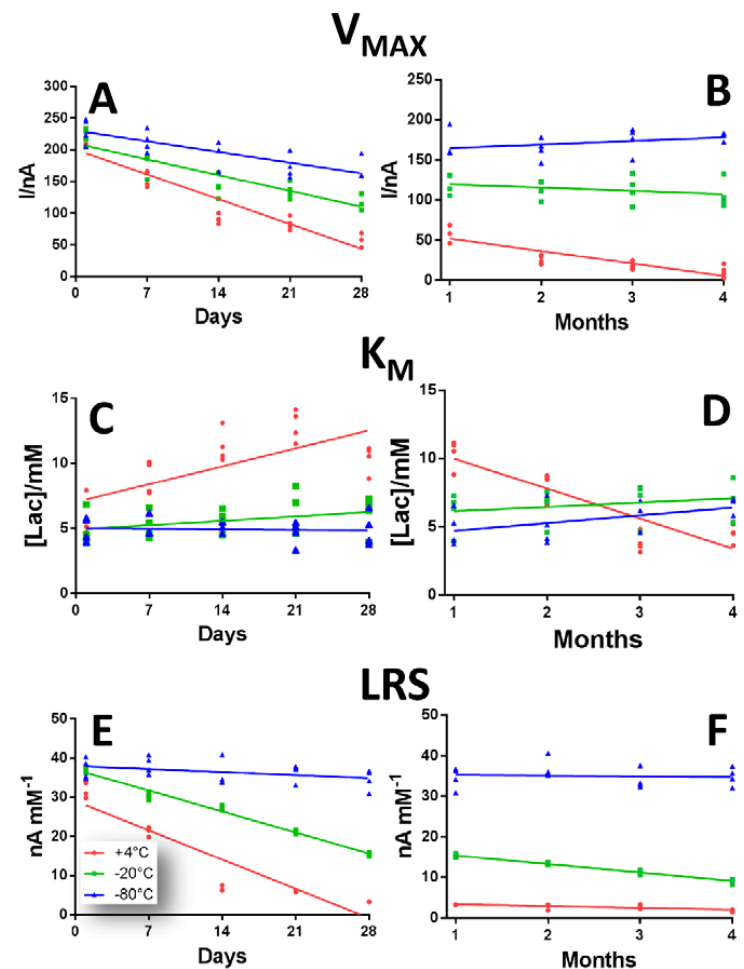
Figure 4. Scattering plot describing the variations of V MAX (Panel A and B), K M (Panel C and D) and LRS (Panel E and F), in a range of 28 days (left inset) and of four months (right inset) of LB1 design Ptc/PPD/[PEI (0.5%)-LOx] 5 / GTA(1%)-BSA (2%) in the defined range of 120 days, when stored at +4 °C (red plot), − 20 °C (green plot) and − 80 °C (blue plot). In panel E and F, the over-time variations of LRS in a range of 28 days (left inset) and of four months (right inset) are displayed, according to the different storage protocol.